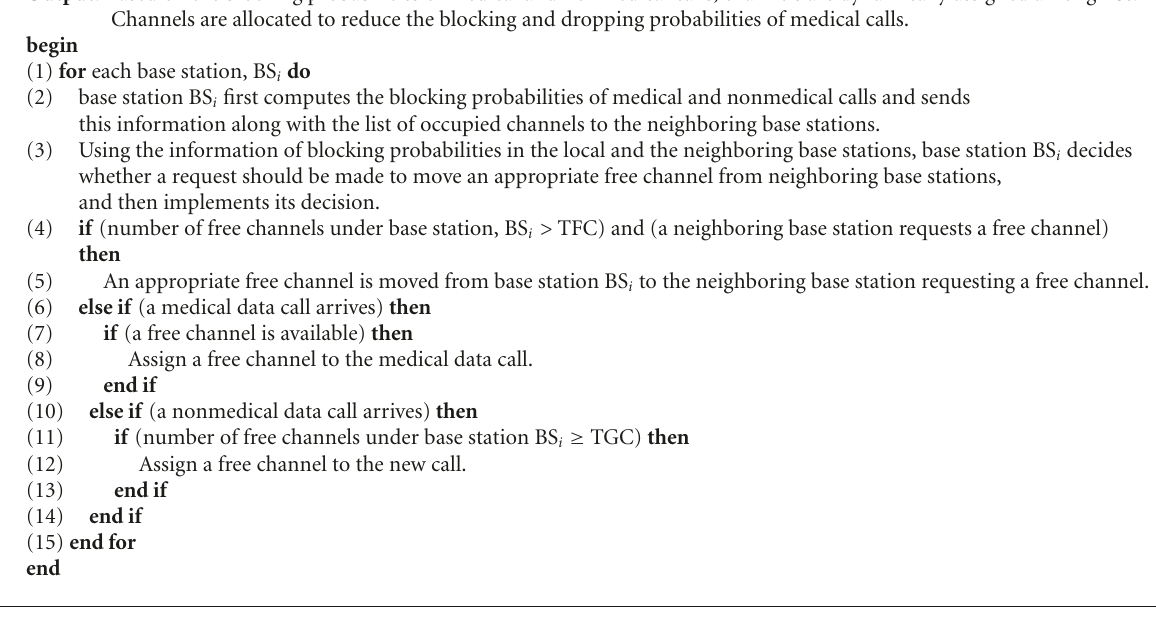
Algorithm 4: Algorithm